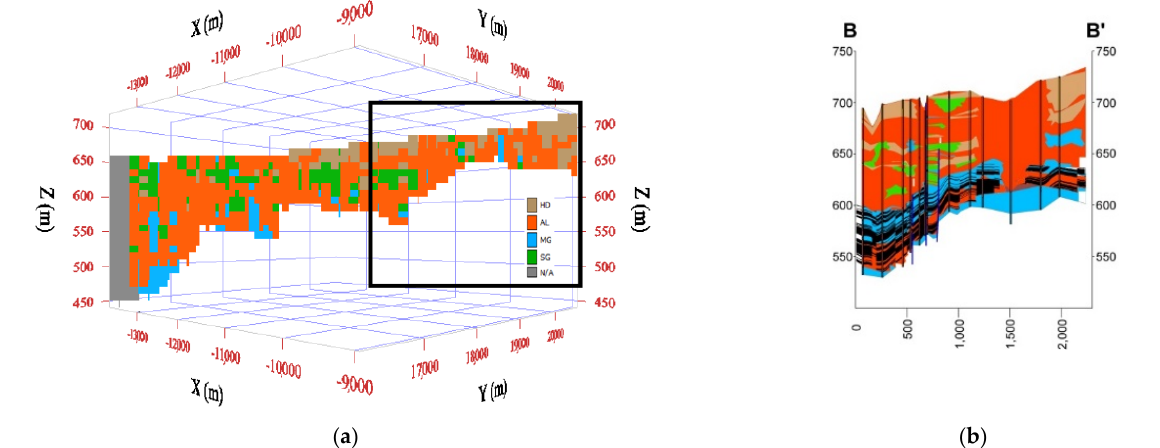
Figure 11. Comparison between ( a ) a realization of the modeland ( b ) reality in Section B–B’. The bold frame shows the model area that corresponds to the real image. In addition, note that the model does not include the lignite beds shown in black color and their interburden and underburden waste layers on Section B–B’.